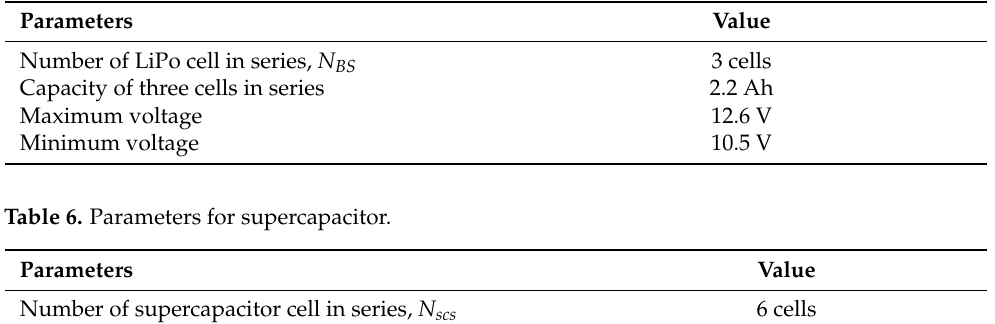
Table 5. Parameters for LiPo battery.